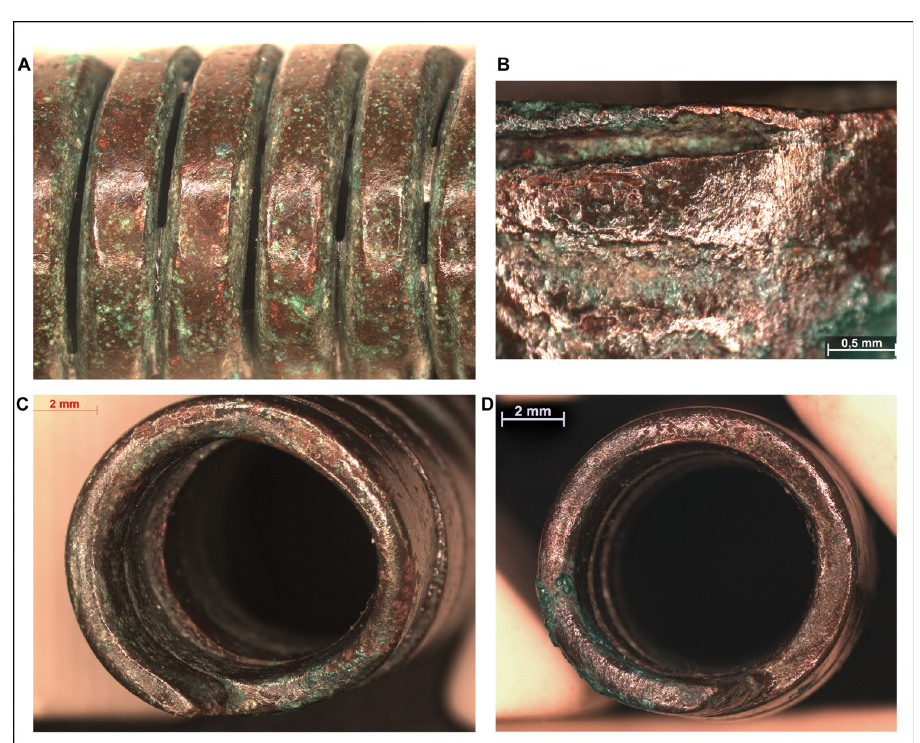
Fig 12. Micrographs showing the macrostructure of tubular spiral coils. Photo: Eszter Horva´th. (A) Coiled copper strip with trapezoidal cross-section (O˝.2019.8.1.22.). (B) Short indentation at the edge of a spiral coil (O˝.2019.8.1.179.). (C–D) Plan view of some selected spiral coils showing uniformity in their wall-thickness and diameter (C. O˝.2019.8.1.51., D. O˝.2019.8.1.179.).